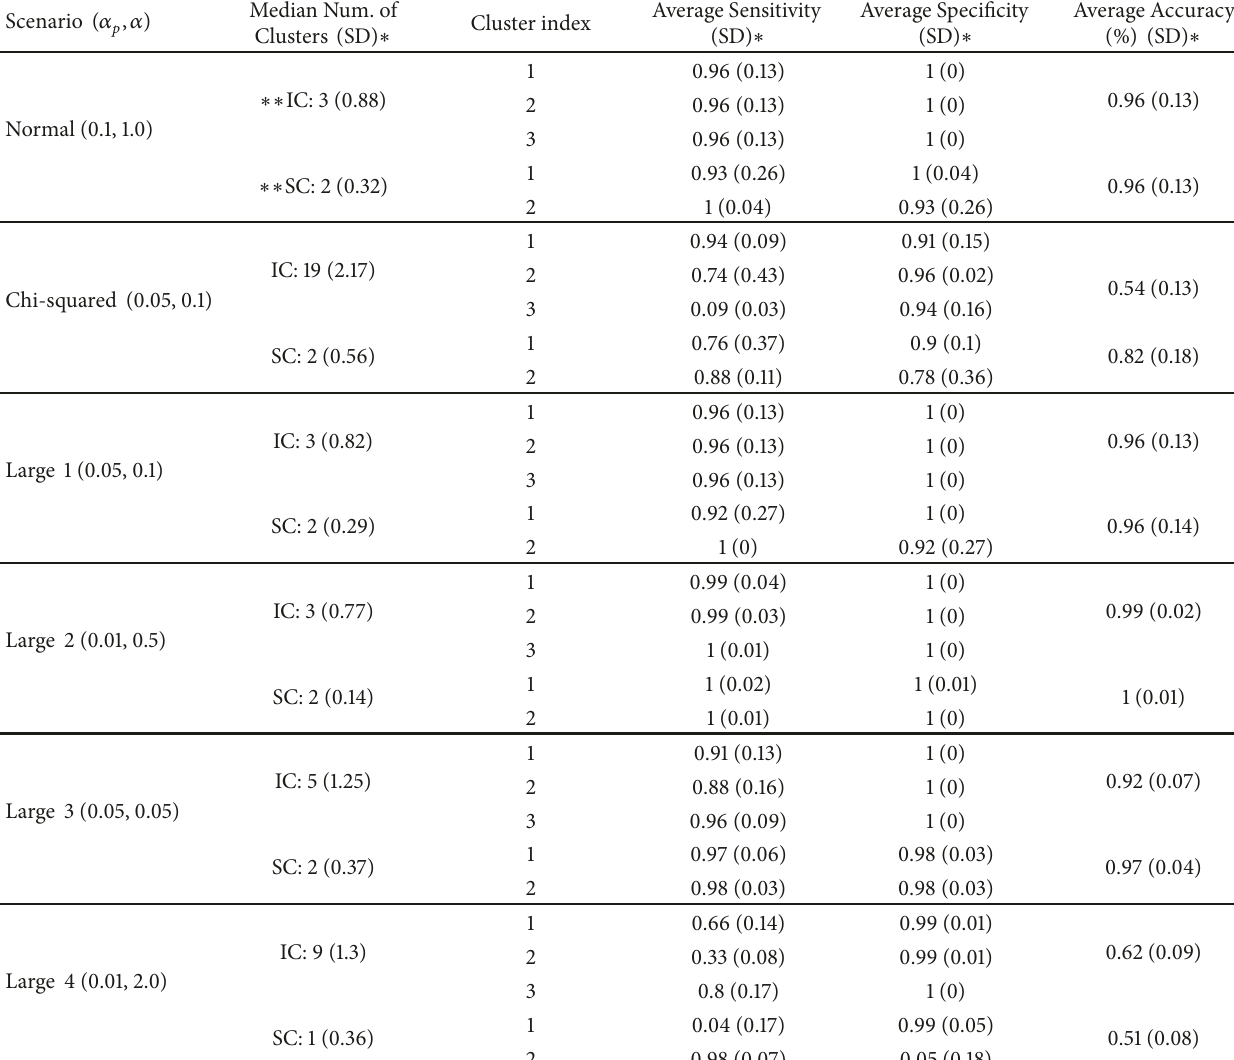
Table 1: Simulation assessments for three foci-level